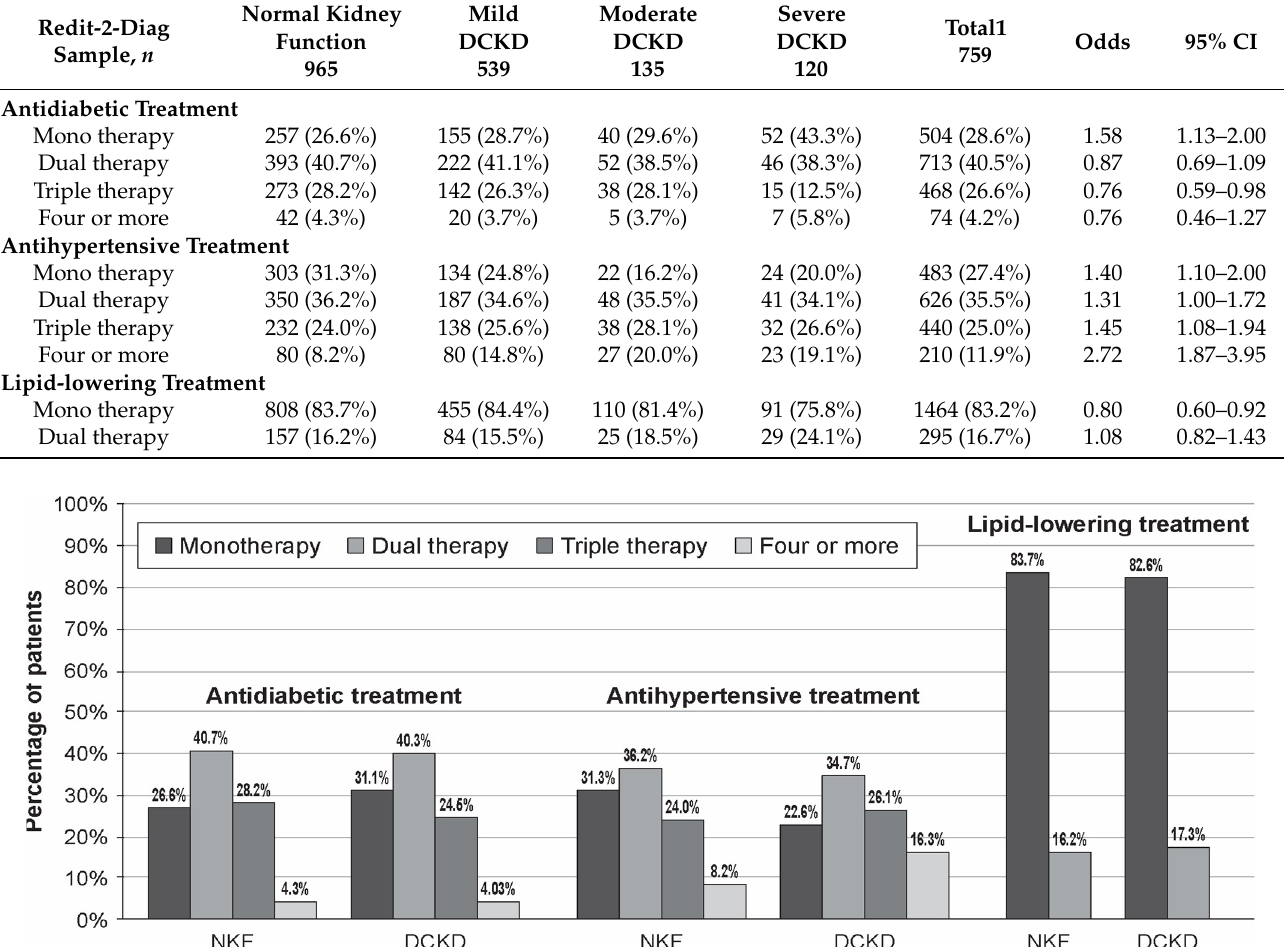
Table 3. Prescribing pattern of antidiabetic and antihypertensive agents in the two-group analysis (normal kidney function vs. DCKD).